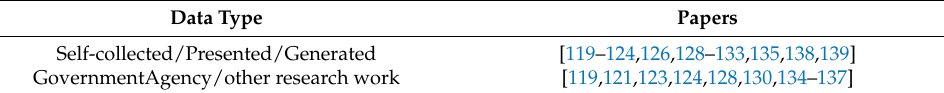
Table 16. Data types for Smart